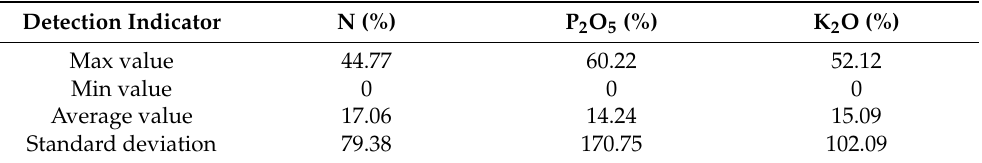
Table 1. Test results of N, P 2 O 5 , and K 2 O content in fertilizer samples. Detection